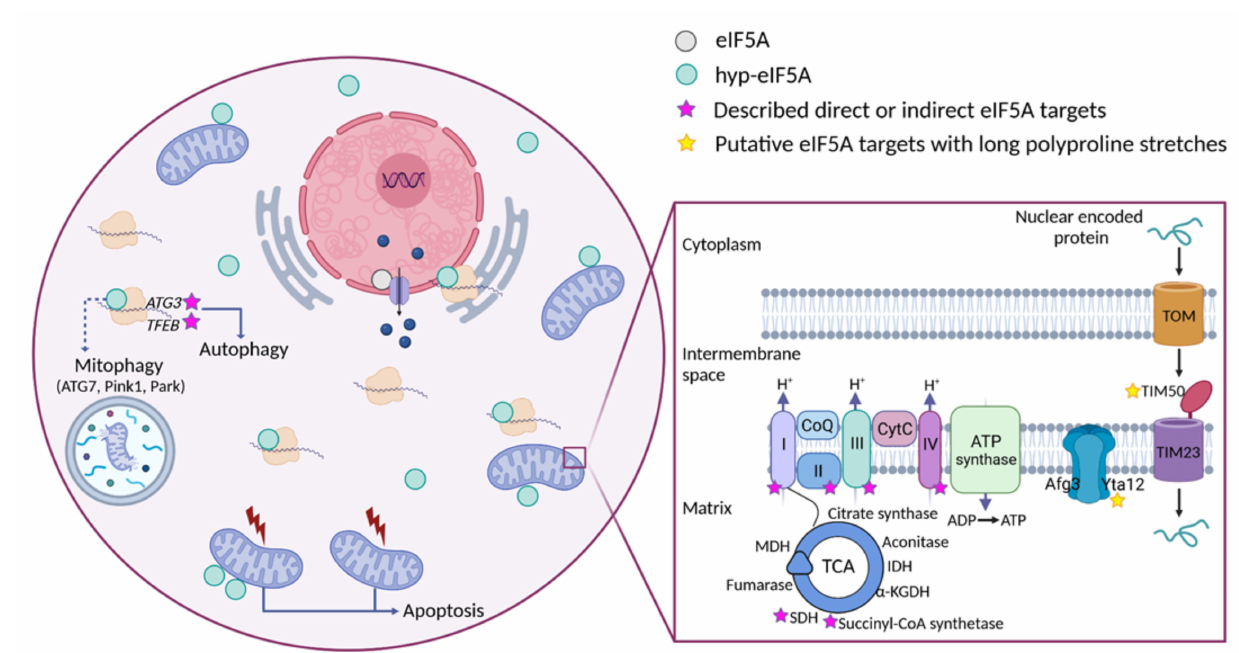
Figure 3. Cellular funtions of eIF5A and model for its role in maintaining mitochondrial activity. eIF5A is known to be implicated in different cellular processes, although the most relevant and mitochondrial-related of these are represented in the Figure. Bound to ribosomes, hyp-eIF5A facil- itates translation elongation at specific motifs [10,11], as well as ER-coupled translation [23,25,26]. In the nucleus, eIF5A helps to export certain mRNAs and proteins [141]. eIF5A plays a controver- sial role in apoptosis, as it has been defined to be necessary to induce the mitochondrial mediated apoptosis [124,146], but also to lead to cell death when inhibited [133]. Hyp-eIF5A promotes au- tophagy through the translation of the autophagy factors ATG3 (autophagy-related 3) and TFEB (transcription factor EB) [42,43]. Increasing evidence shows a direct link between hyp-eIF5A and mitochondrial function. In addition to its association with mitochondria [143–146], some proteins of both the TCA and ETC have been described to be directly or indirectly affected under hyp-eIF5A in- hibition [126,147]. It has also been proposed that hyp-eIF5A could mediate mitophagy through ATG7 (Autophagy Related 7), Pink1 (the mitophagy-associated PTEN-induced putative kinase), and Park (the E3 ubiquitin ligase Parkin) proteins [170]. Other proteins involved in the mitochondrial transport of nuclear-encoded proteins and mitochondrial organization are considered as putative eIF5A targets (Figure 2). Among these, the mitochondrial inner-membrane integral proteins Yta12 (protease of the Yta12/Afg3 complex and yeast homolog of human AFG3L2), and Tim50 (essential subunit of the TIM23 complex and yeast homolog of human TIMM50) contain long polyproline stretches in their amino acids sequences, suggesting a possible dependence on eIF5A for their translation and, thus, a possible link between hyp-eIF5A and mitochondrial function. Figure processing was carried out using BioRender